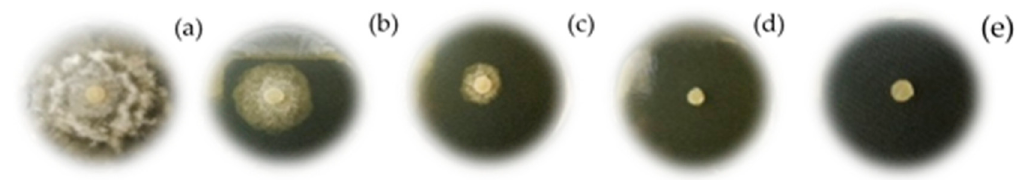
Figure 2. In vitro effect of 2-allyl-4,6-dinitrophenol ( 9 ) on mycelial growth of Phytophthora cinnamomi at different concentrations: ( a ) 0 µg/mL (Negative control); ( b ) 10 µg/mL; ( c ) 25 µg/mL; ( d ) 50 µg/mL; ( e ) METALAXYL MZ 48 WP at 10 µg/mL, used as positive control.